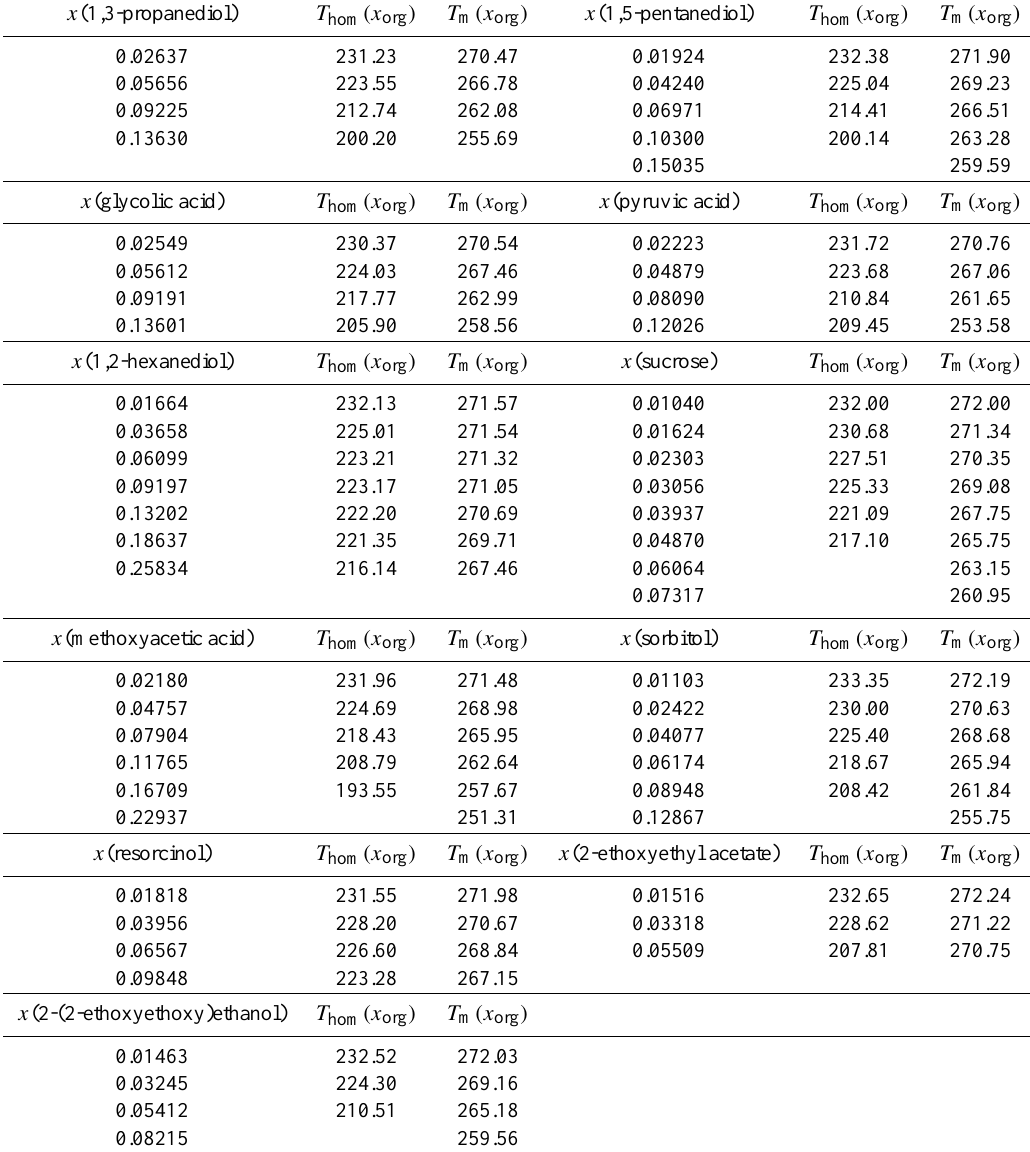
Table 2. Homogeneous ice freezing T hom (x org ) and ice melting T m (x org ) temperatures of the investigated aqueous organic solutions. Solution compositions are expressed in mole fraction x (organic) and temperature in K.